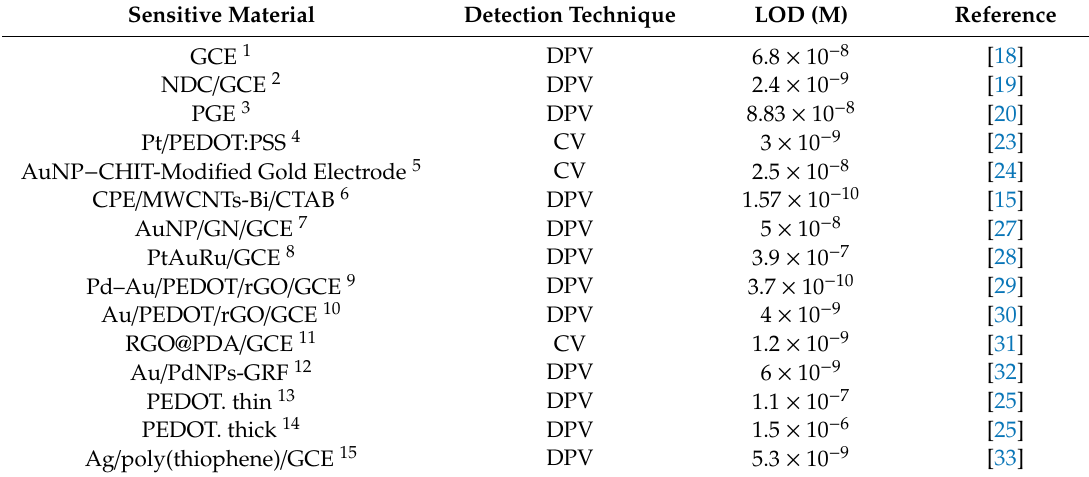
Table 1. Sensitive materials, detection techniques and detection limits (LODs) of the main voltammetric sensors used for the detection of ca ff eic